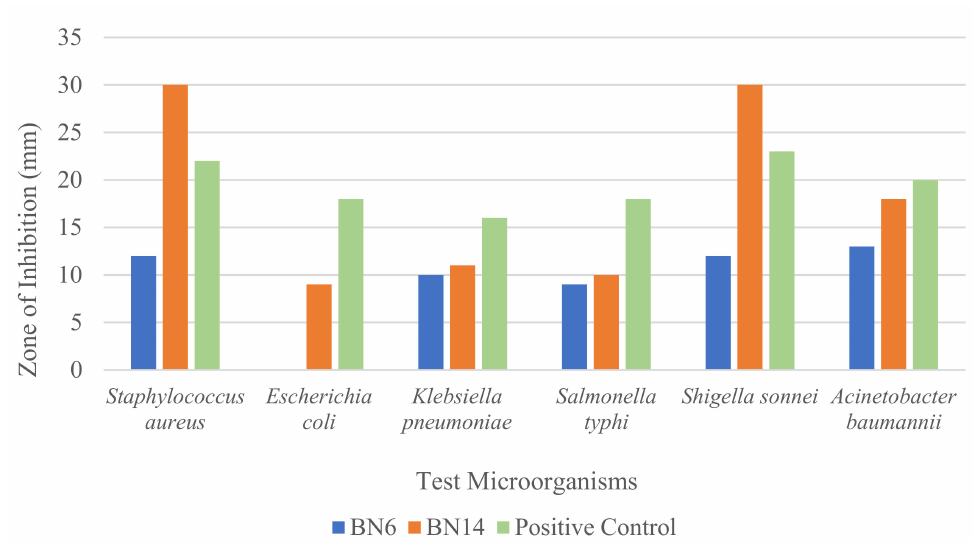
Figure 4. A bar chart showing the zone of inhibition exhibited by extracts of BN6 and BN14 isolates (5 µ g extract in each well and 1 mg/mL